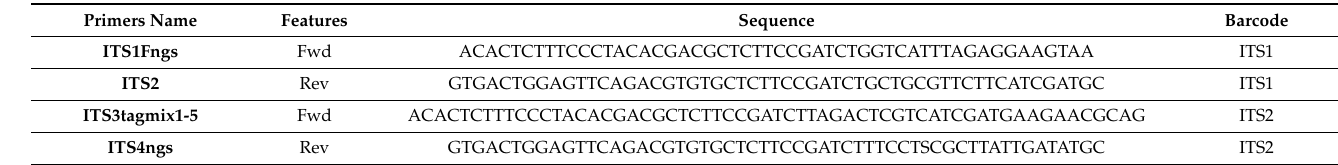
Table 1. Primers used for amplification of the Internal Transcribed Spacers 1 and 2 (ITS1 and ITS2)